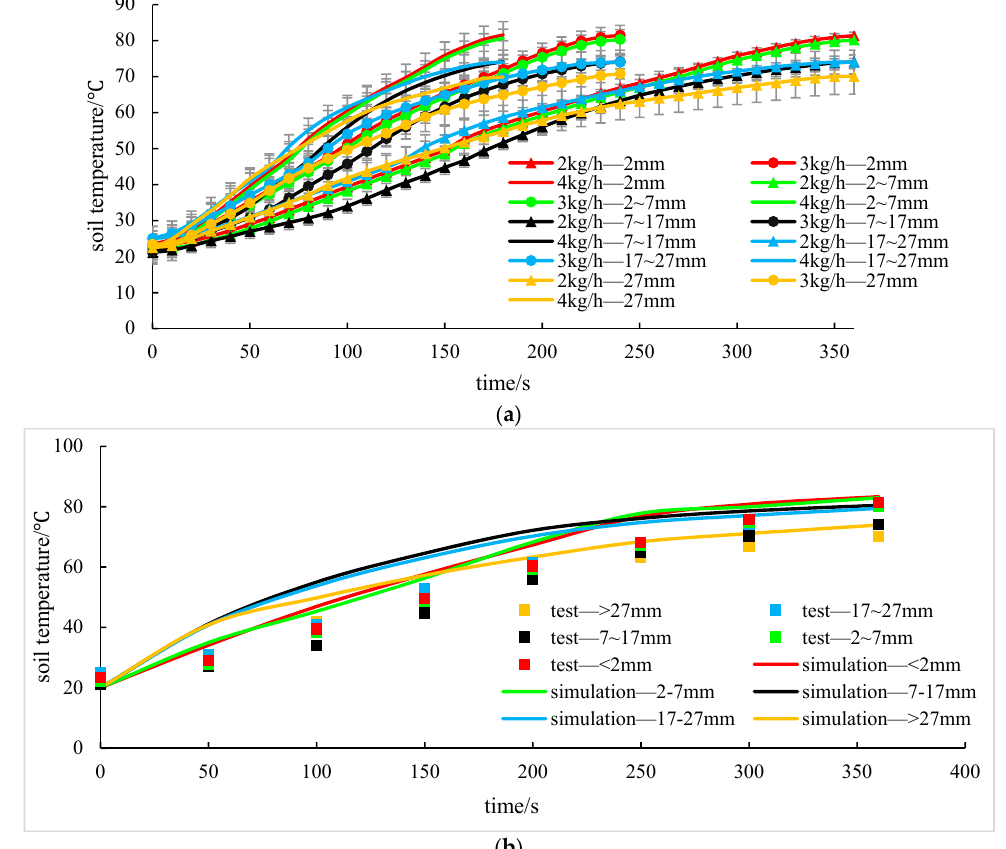
Figure 9. Mean ST with time. ( a ) Soil temperature-time change under different flow and particle size test conditions; ( b ) Soil temperature-time simulation and experimental comparison of different particle size conditions at a flow rate of 2kg/h. Note: 2 kg/h-2 mm means that the steam flow of the treatment group is 2 kg/h, and the particle size of the soil is <2 mm. The same conditions apply in the following section.